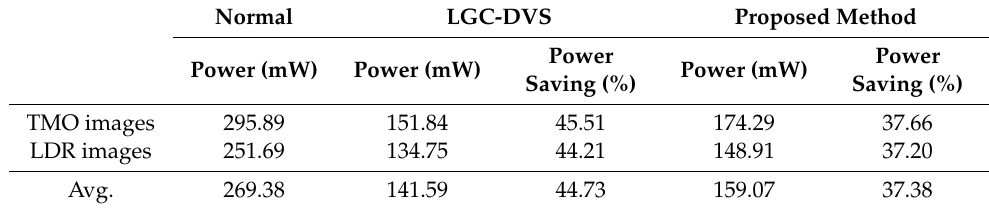
Table 2. Comparison of power consumption and power-saving